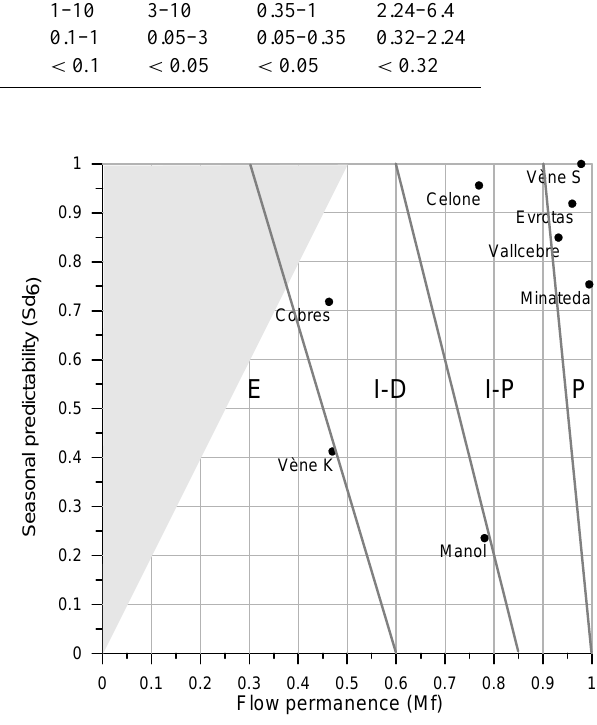
Fig. 6. Plot of the stations studied using the two regime metrics tested: flow permanence (Mf) and seasonal predictability of the zero-flow months (Sd 6 ) . The oblique grey lines show the approx- imate interim separation between the four regime types: P (Perma- nent), I-P (Intermittent-pools), I-D (Intermittent-dry), E (Episodic- ephemeral). The grey triangle shows a field where the metric values are